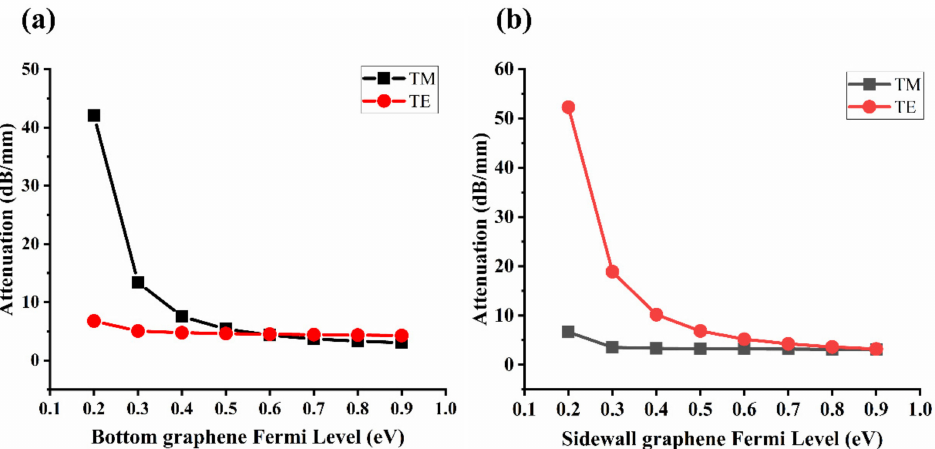
Figure 7. ( a ) Attenuation of the quasi-TE and the quasi-TM modes versus the Fermi level of bottom graphene and with zero biasing on the sidewall graphene. ( b ) Attenuation of the quasi-TE and the quasi-TM modes versus the Fermi level of the sidewall graphene and with zero biasing on the bottom